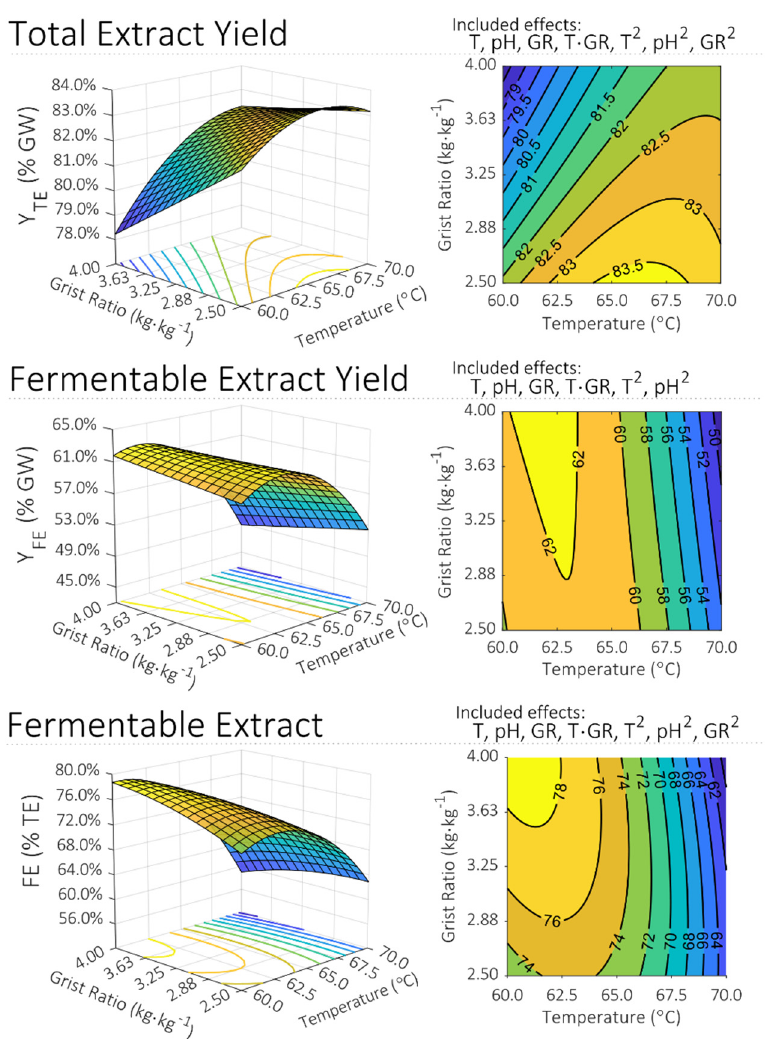
Figure 4. Response surfaces and contour plots for Y TE , Y FE , and fermentable extract (FE). For the response surfaces and contour plots above, pH is held at its center-point value of 5.30. Table 4. Compiled response model fit statistics.